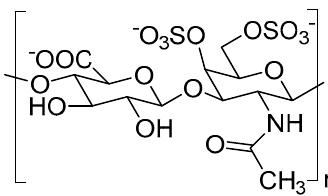
Figure 2. Chemical structure of chondroitin-4,6-disulfate or CS-E.